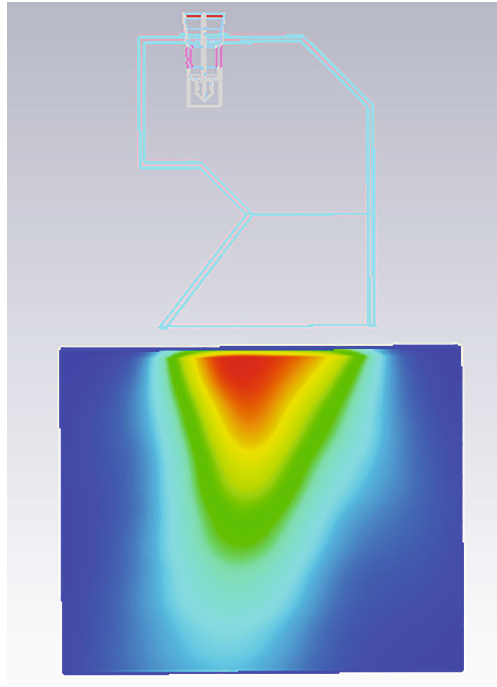
Figure 5: The simulation model.